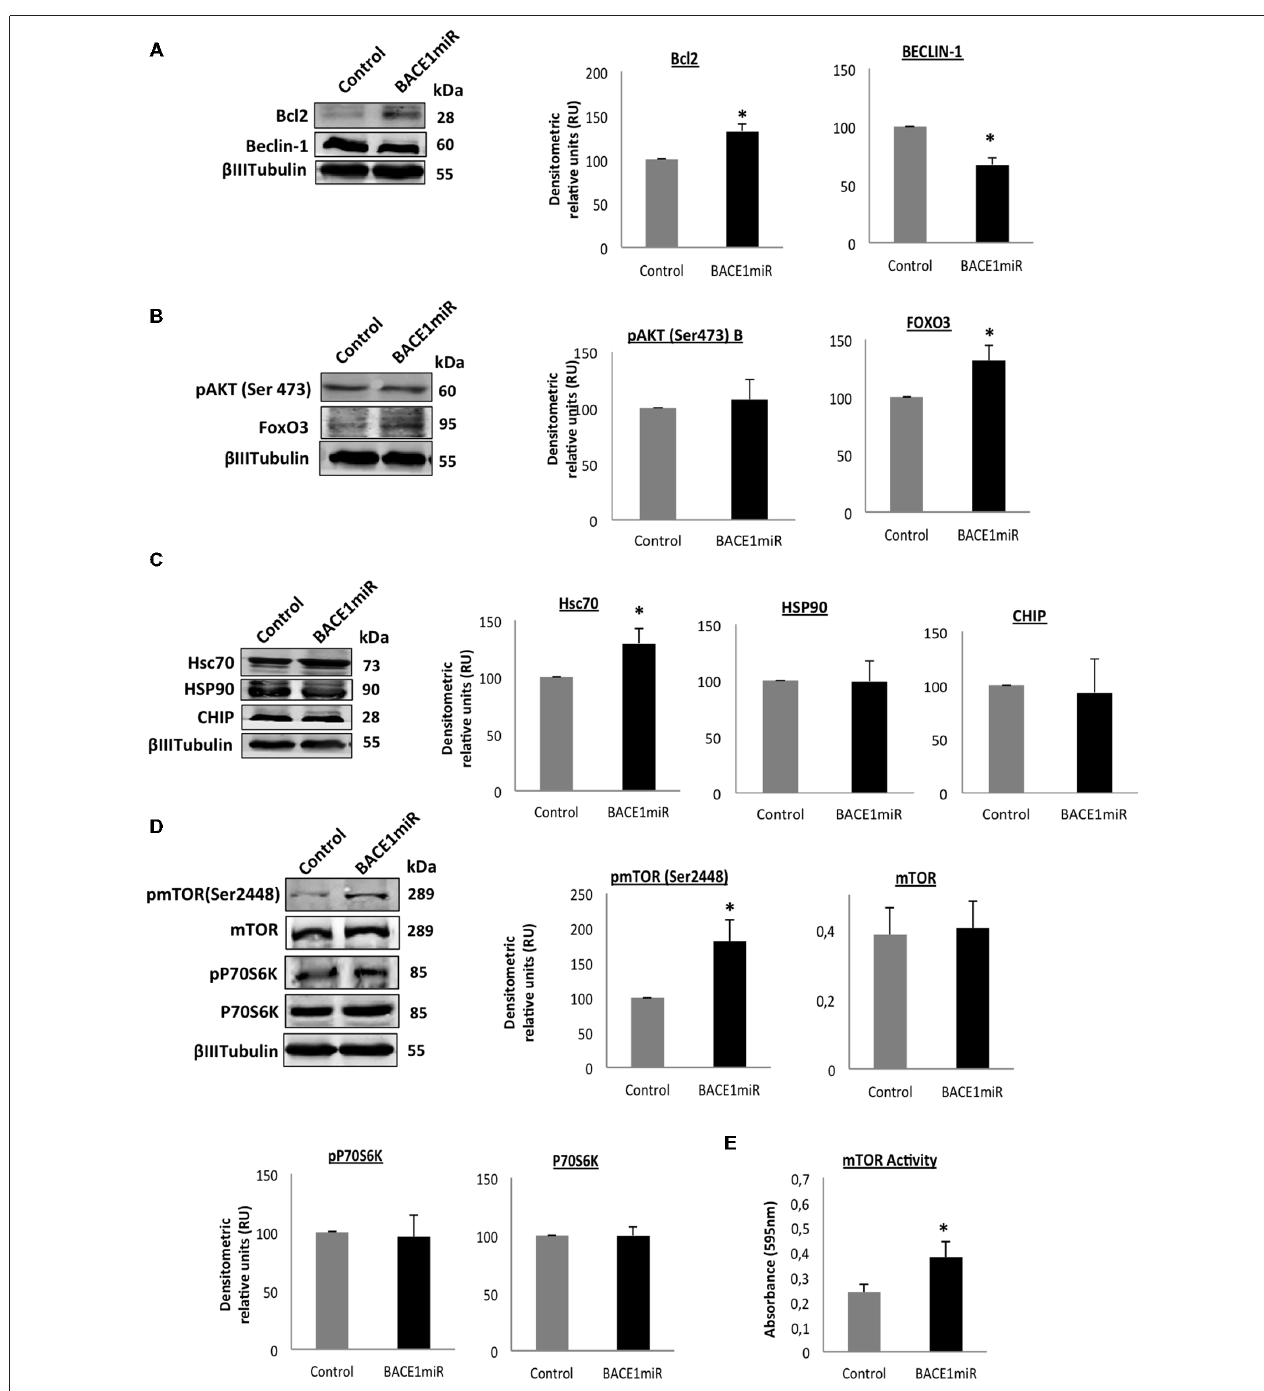
FIGURE 8 | Silencing of BACE1 upregulates the survival signaling in 3xTg-AD mice. Survival and quality control regulation pathways were analyzed. (A) Bcl2/Beclin-1, (B) Akt/FoxO3, (C) Hsc70/Hsp90/CHIP protein levels, (D) mTOR pathway and its activity (E) from the hippocampi of 3xTg-AD mice 24-month-old after 6 months of injection with AAV2/5-BACE1miR and AAV2/5-GFP version as control. Representative blots are shown. RU = relative unit. n = 4, ∗ p < 0.05.